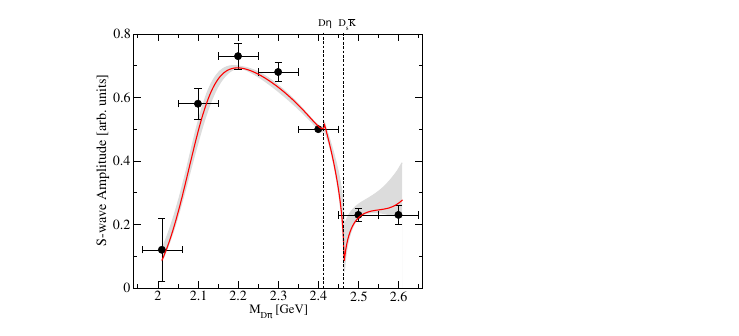
Figure 2. Comparison of the the S -wave amplitude determined in Ref. [44] with the one extracted in FIG. 4. Comparison of the S -wave amplitude determined in the experimental analysis in Ref. this work to the S -wave anchor points found in the experi- mental analysis, shown as the data points [46]. The red line gives the best fit results and the grey band quantifies the uncertainties that emerged from the fitting procedure. The fitting range extended up to 2.55 GeV. The dashed perpendic- ular lines indicate the location of the Dη and D s ¯ K threshold, respectively.